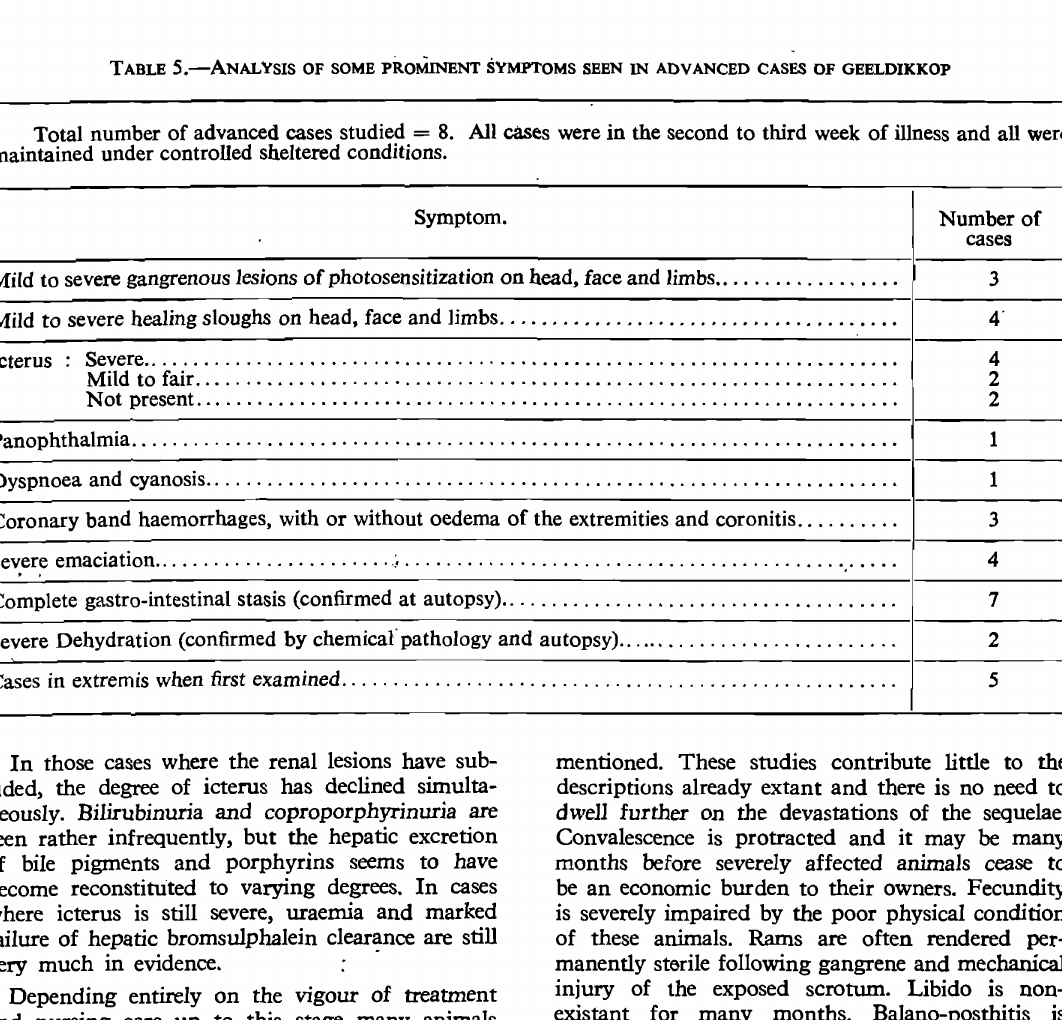
Total number of advanced cases studied = 8. All cases were in the second to third week of illness and all were maintained under controlled sheltered conditions.